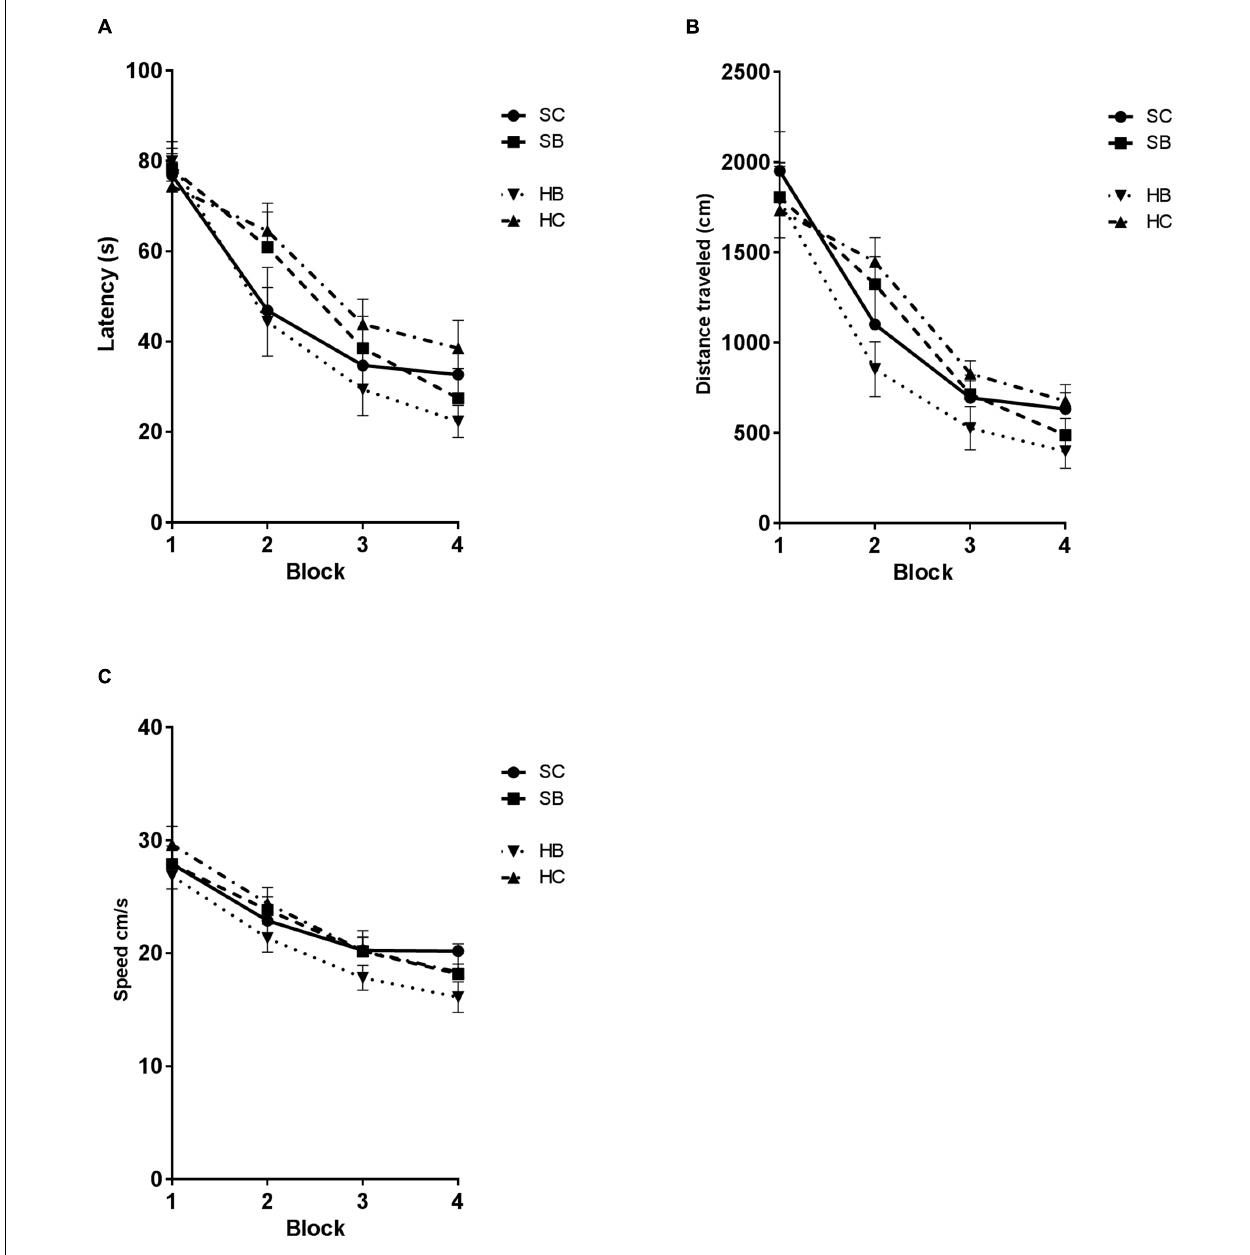
FIGURE 6 | Hyaluronidase infusion attenuated blast induced deficits in the Morris Water maze task. Line graph depicts mean MWM trial latencies over four consecutive blocks of trials (A) . Saline infused blast exposed rats (SB) showed an increase in latency relative to sham blasted controls (SC) (51.3 s vs. 47.8 s; p = 0.0293). Whereas, blast exposed rats that received hyaluronidase infusion (HB) had a significantly decreased latency to platform when compared to saline treated blasted animals (SB) (44.0 s vs. 51.3 s.; p = 0.0326). Sham blasted control rats that received hyaluronidase infusion (HC) had similar MWM performance compared to their saline infused blast exposed counterparts (SB) (55.3 s vs. 51.3 s; p > 0.05). Furthermore, the HC treated group had significantly increased latency when compared to SC treated group (56.25 s vs. 46.69 s; p = 0.0259). Line graph depicts mean MWM trial distance over four consecutive blocks of trials (B) . Distance was significantly different between groups [One-way RM ANOVA: exposure F (3,45) = 6.331, P = 0.0011; time F (15,45) = 32.51, P = 0.0001]. HB rats took significantly shorter routes to the platform when compared to the SC group (890.9 cm vs. 1095 cm; p = 0.0247), the HC group (890.9 cm vs. 1183 cm, p = 0.0007), and the SB group (890.9 cm vs. 1083 cm, p = 0.0313). Line graph depicts mean MWM trial swim velocity over four consecutive blocks of trials (C) Swim velocity was significantly different between groups [One-way RM ANOVA: exposure F (2.355,35.32) = 7.291, P = 0.0014; time F (15,45) = 24.18, P < 0.0001]. HB rats swam significantly slower when compared to the SC group (20.53 cm/s vs. 22.81 cm/s; p = 0.0071), the HC group (20.53 vs. 23.15, p = 0.0006), and the SB group (20.53 vs. 22.52, p = 0.0389).